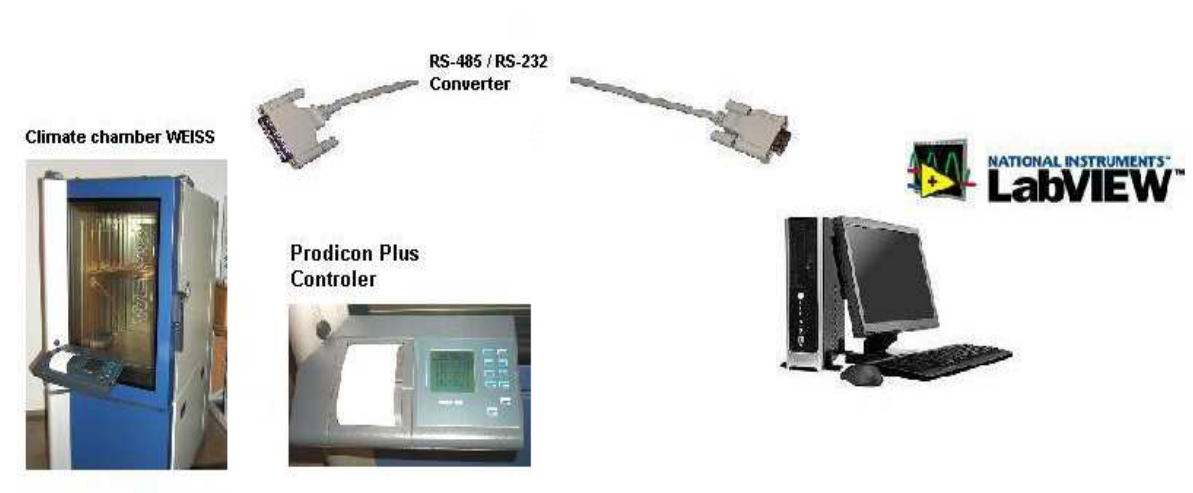
Figure 1 . Main components of the